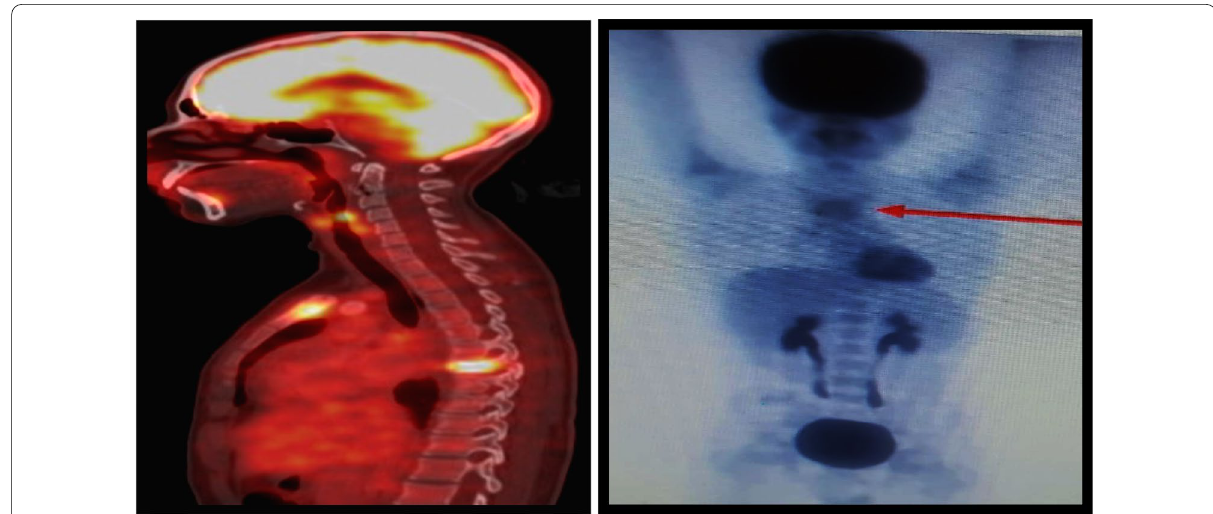
Fig. 5 PET‑CT study for a 15‑year‑old male child complaining rapidly growing anterior chest wall mass that was pathologically proved to be HL, nodular sclerosis type. To the left: Initial study shows metabolically active FDG‑avid osseous infiltrates at manubrium sterni and DV7. To the right: Interim PET‑CT study shows complete disappearance of DV7 lesion with a still residual lesion at sternum with SUVmax ~ 2.2. The interpretation of this study using DS showing a positive result score 4 as sternal activity is higher than that of liver, while rDS (liver max 1.8). The patient was free till the last follow‑up (36 months)